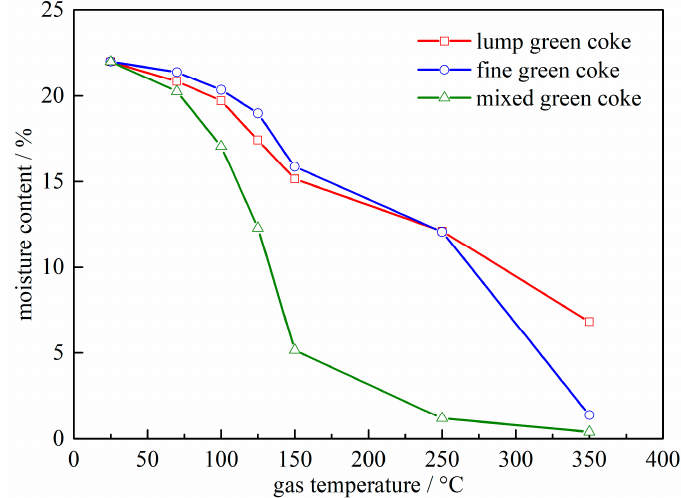
Figure 7. Relationship between moisture content and gas temperature.